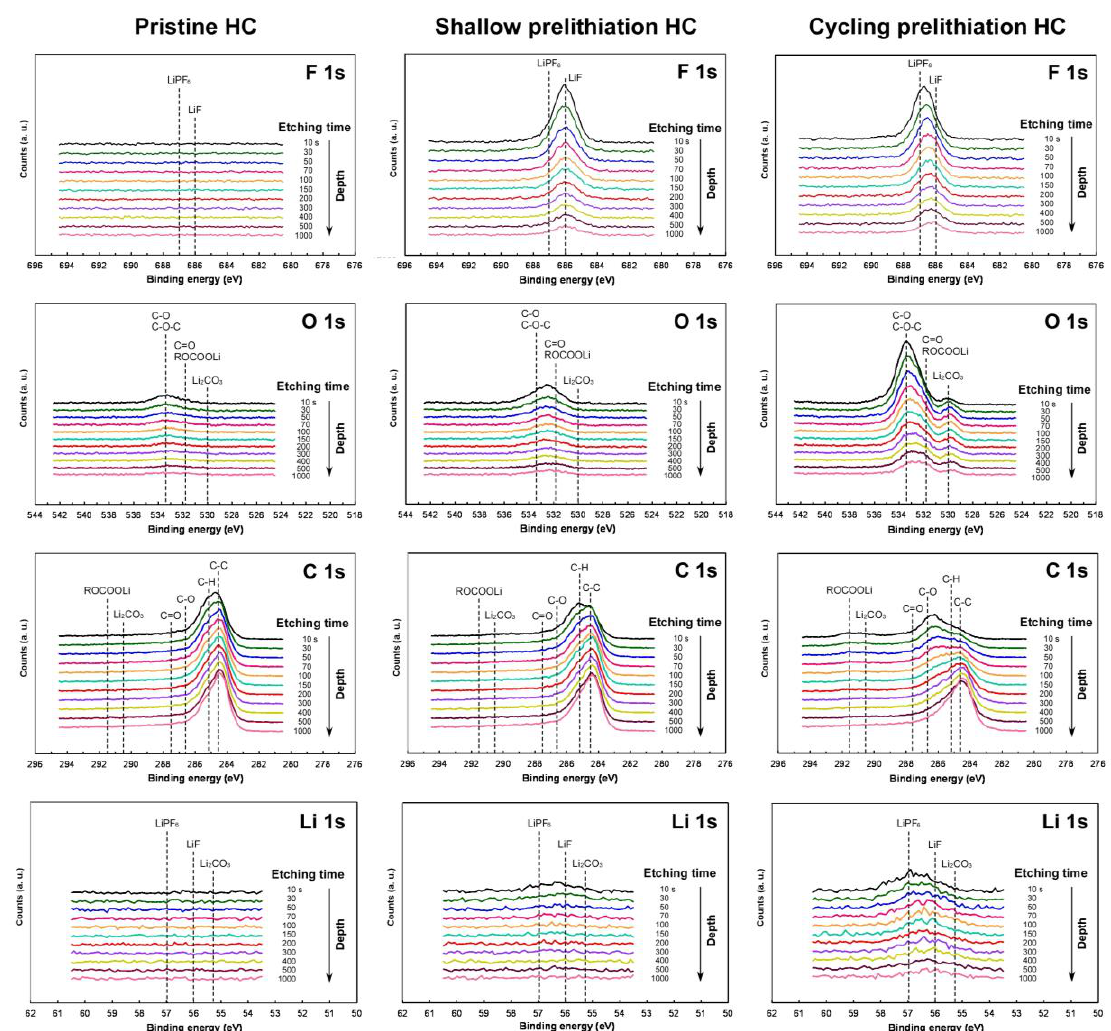
Figure 9. XPS depth profiles of the pristine and prelithiated HC electrodes obtained by Ar ion etching. The etching rate (SiO 2 ) is 0.167 nm s −1 .